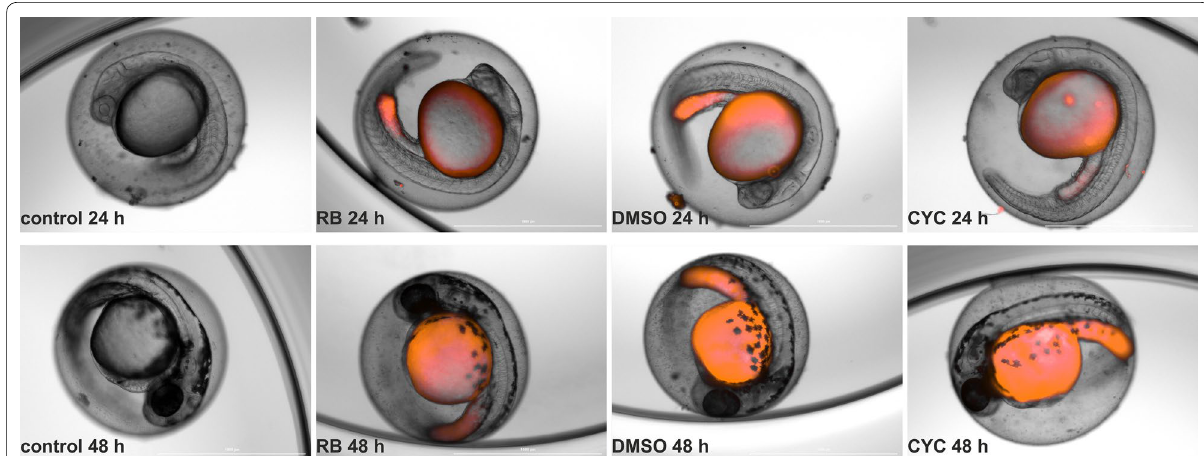
Fig. 4 Localization of rhodamine B in zebrafish embryos and larvae exposed for 24 and 48 h. Control—zebrafish in embryo medium; RB—zebrafish in embryo medium followed by incubation in rhodamine B; DMSO—zebrafish in DMSO followed by incubation in rhodamine B; CYC—zebrafish in cyclosporine A followed by incubation in rhodamine